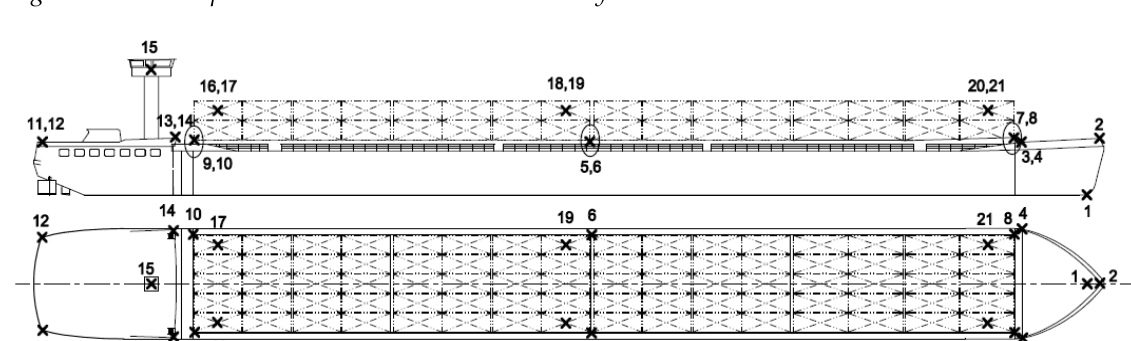
Figure 4a. Critical points to be considered in a risk analysis: tanker.